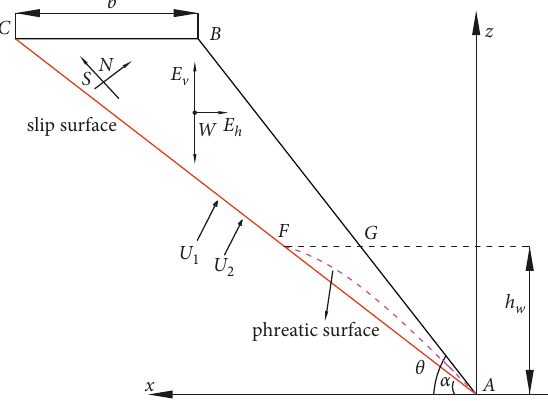
Figure 4: Forces acting on the slip